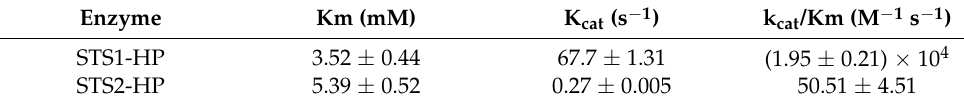
Figure 1. Screening STS1 and STS2 phosphatase inhibitors from natural small molecules. ( A ) Expression and purification of STS1 and STS2 histidine phosphatase (HP) domain recombinant proteins. Purified proteins were analyzed in 12% SDS − PAGE followed by Coomassie blue staining. ( B ) Schematic diagram of STS1 and STS2 phosphatase inhibitor screening. The reaction was carried out at room temperature. ( C , D ) Inhibition ratios of compounds (10 μ g/mL) on STS1 ( C ) and STS2 ( D ) phosphatase activities. Probability values ( p − value) indicate statistical significance. The green dot in the red circle represents baicalein (BC). ( E ) Inhibition ratios of BC (10 μ g/mL) on STS1 and STS2 phosphatase activities ( n = 6). The data represent the means ± SEM. ( F ) The chemical structure of BC. Table 1. Kinetic constants of STS proteins.